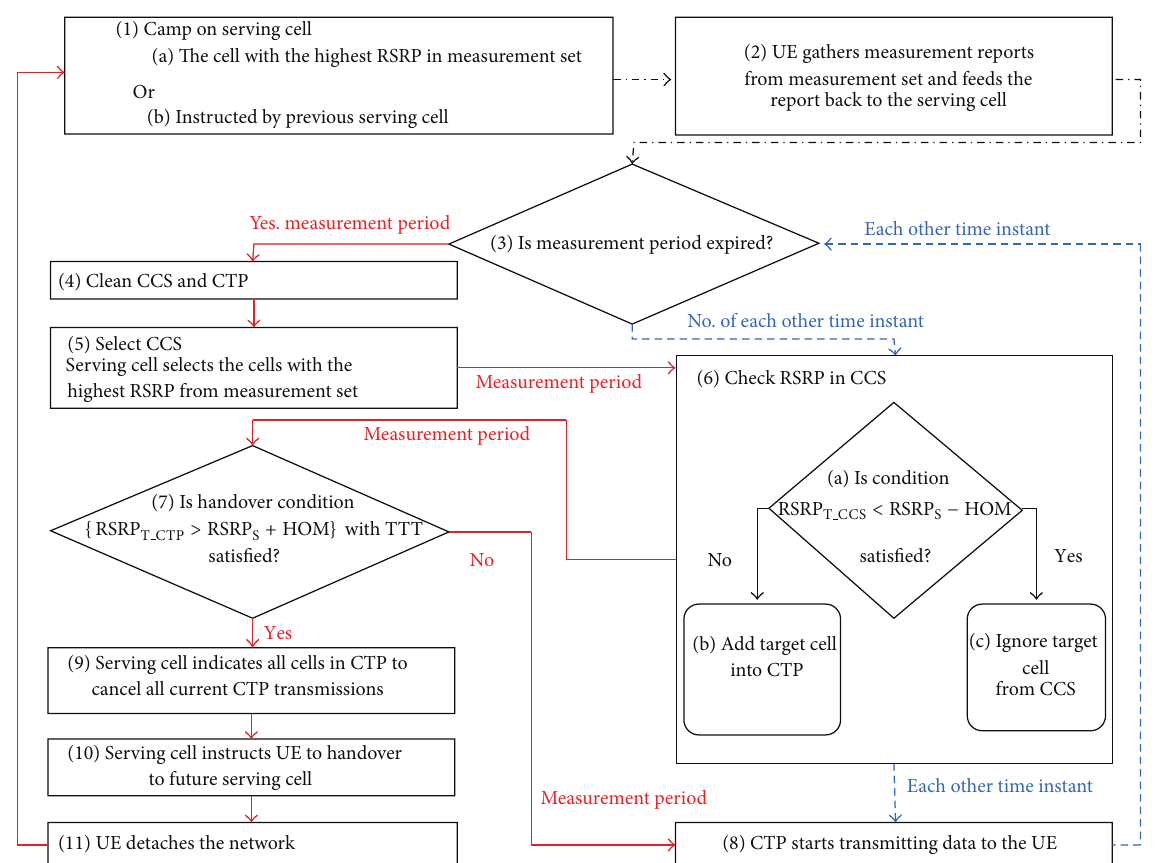
Figure 5: Flowchart of Limited CoMP Handover Algorithm in